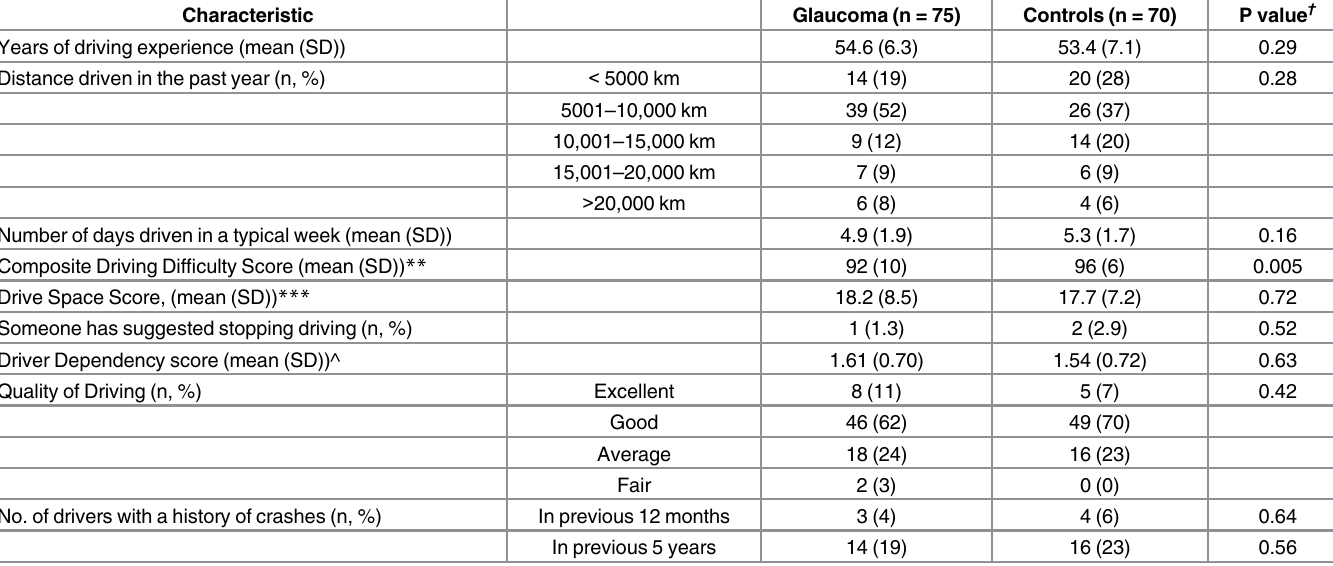
Table 2. Self-reported driving characteristics of the participants as determined from DHQ